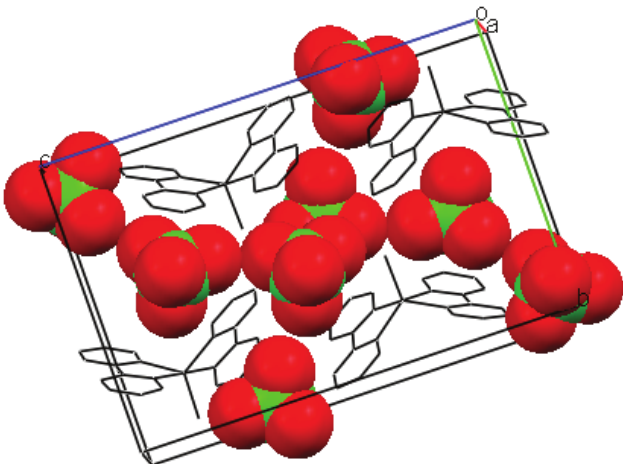
Figure 1. Cell of complex {[Zn(bipy) 2 (H 2 O)](ClO 4 ) 2 }( 1 ) .